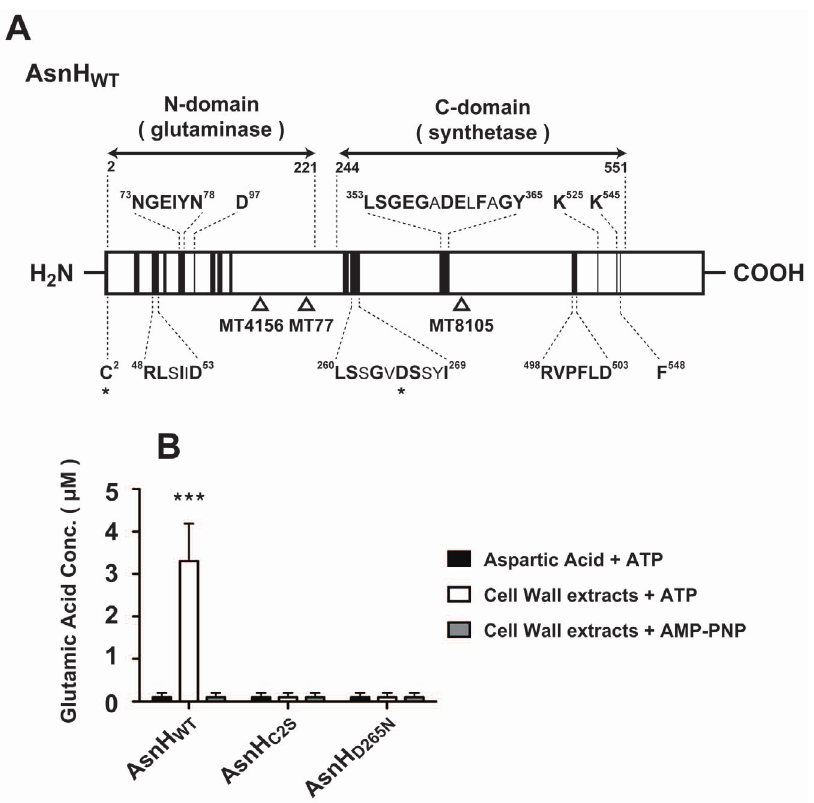
Figure 3. Schematic diagram of L.casei AsnH and glutaminase activity of AsnH proteins. (A) Protein sequence alignment was performed using the GENETYX program. Solid boxes indicate highly conserved regions. Regions containing residues important for enzymatic activities are shown in detail (identical residues are indicated by boldface type). The first methionine was consistently included in the numbering and was designated Met-1. Asterisks indicate mutated residues in this study that were critical to glutaminase or synthetase activities. (B) Recombinant AsnH WT , mutant AsnH C2S , and mutant AsnH D265N (0.1 m g) were examined using the glutaminase activity test. Five microliters of a reaction mixture (initial volume, 50 m l) were quenched at 30 min to estimate glutamic acid concentration. Glutaminase activity was monitored in the presence of aspartic acid or cell wall extracts of ATCC 27139, ATP or AMP–PNP plus cell wall extracts. Results are depicted as the means 6 standard deviations (SD). Statistical significance was calculated using the Student’s t -test. Significant differences indicated between the control and treated groups. ***, p ,